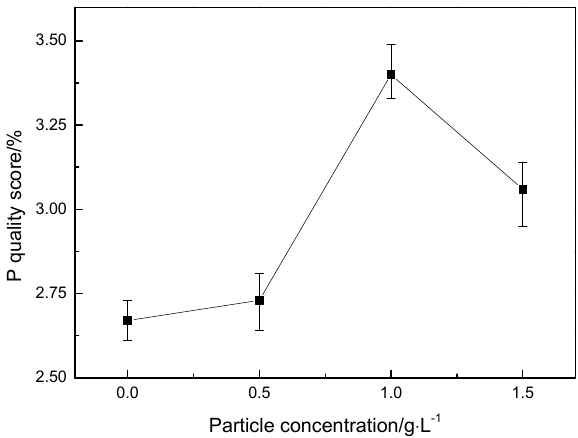
Figure 5. P mass fraction of coatings with different concentration of nano-CeO 2 particles.